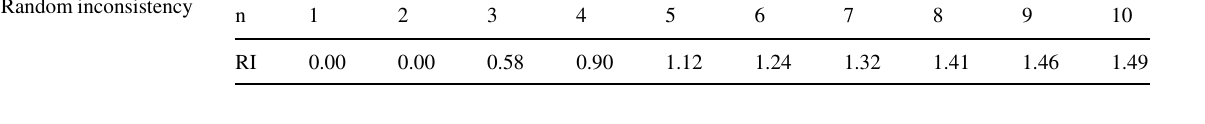
Table 10 Random inconsistency